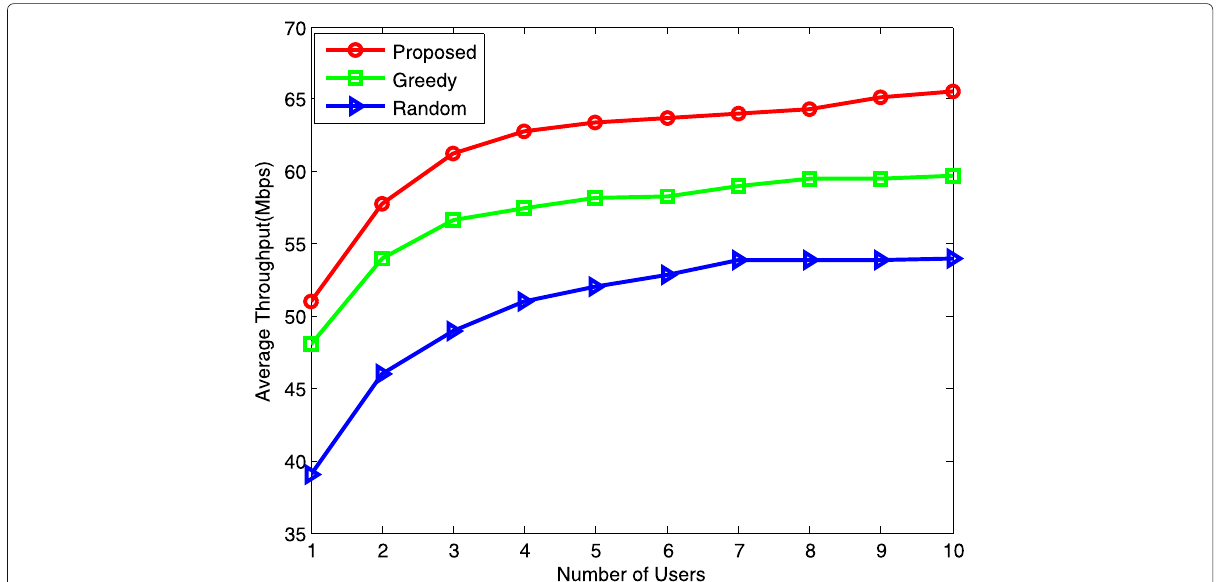
Fig. 7 Average throughput results for proposed framework versus greedy and random